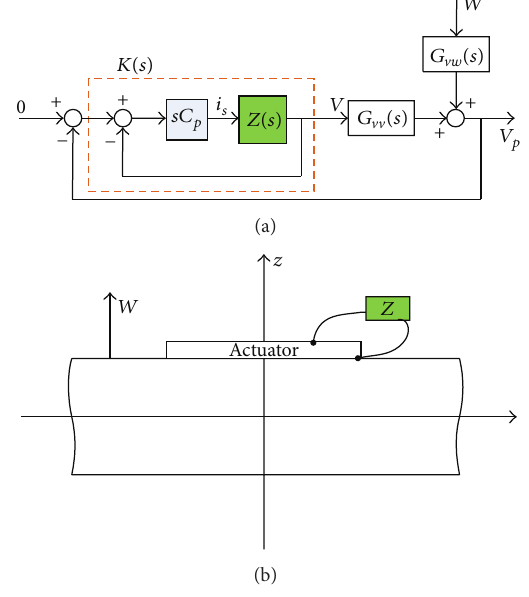
Figure 2: Feedback representation of the shunt control (a) and a structure subject to disturbance 𝑊 and damped using a piezoactua- tor shunted to an electric impedance Z